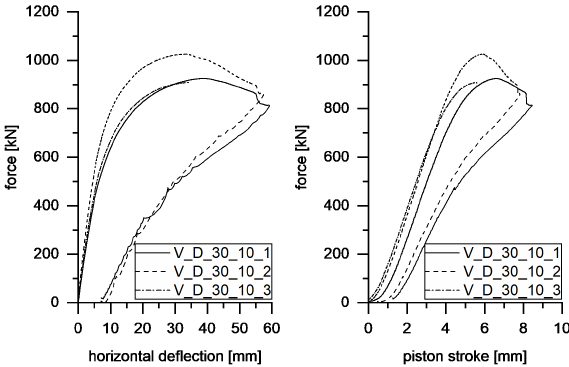
Figure 9. Force-horizontal deflection and force- piston stroke diagram for 10 ă mm eccentrically loaded experiments [5].